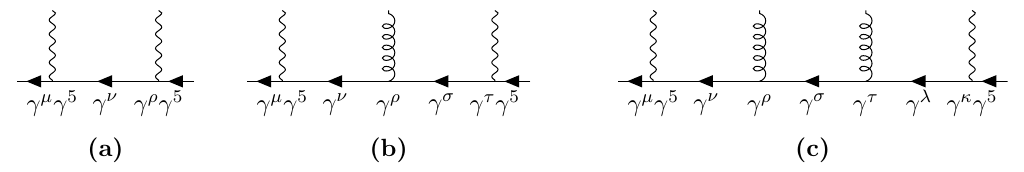
. Figure 5a corresponds to triangle gg ! d (cid:22) dH